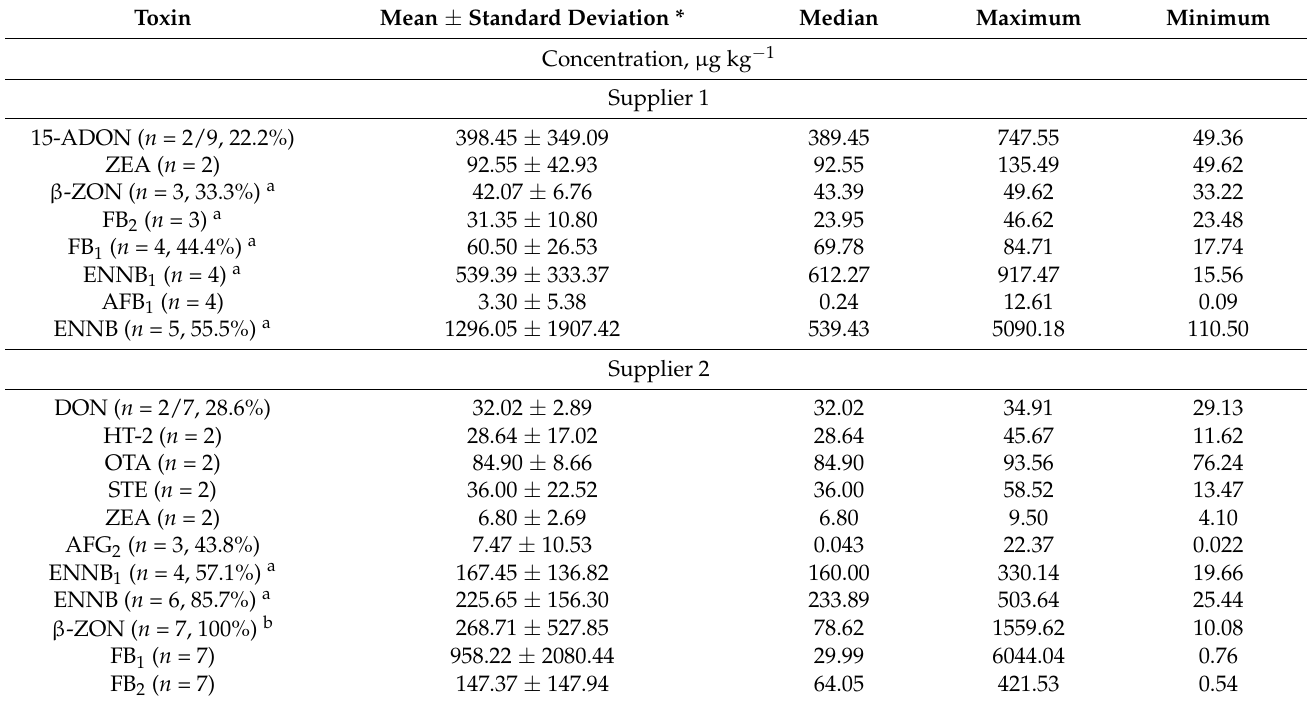
Table 3. Descriptive and comparative analysis of mycotoxins carried out on different batches of balanced feed for laboratory animals from two different companies.